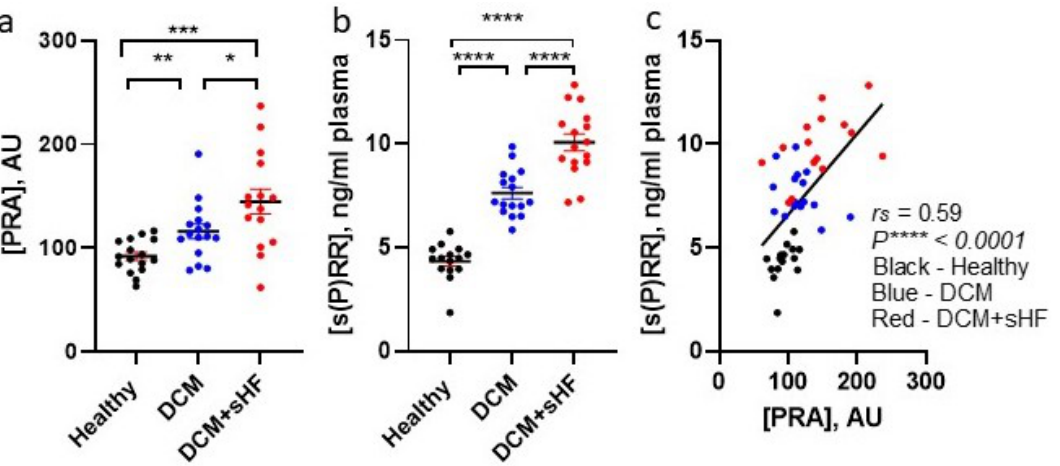
Figure 1. Plasma renin activity (PRA) [18] ( a ) and soluble (pro)renin receptor, s(P)RR ( b ) levels alteration in clinical DCM and symptomatic HFrEF. ( c ) Spearman correlation of PRA vs. s(P)RR. Arbitrary units (AU). Comparisons between groups were analyzed with Mann–Whitney multiple comparison; * p < 0.05, ** p < 0.01, *** p < 0.001, and **** p < 0.0001. Black: healthy—no HF and normal EF; Blue: DCM (dilated cardiomyopathy)—pre-symptomatic HFrEF; Red: DCM + sHF (HF symptoms)—symptomatic HFrEF.